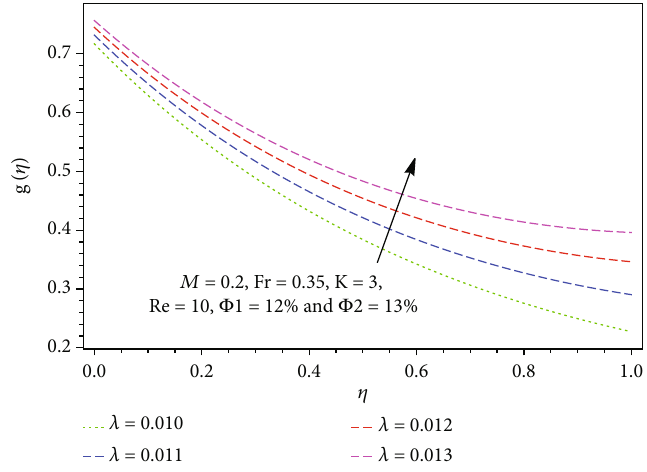
Figure 9: Impact of porosity parameter λ over momentum pro fi le g ð η Þ .